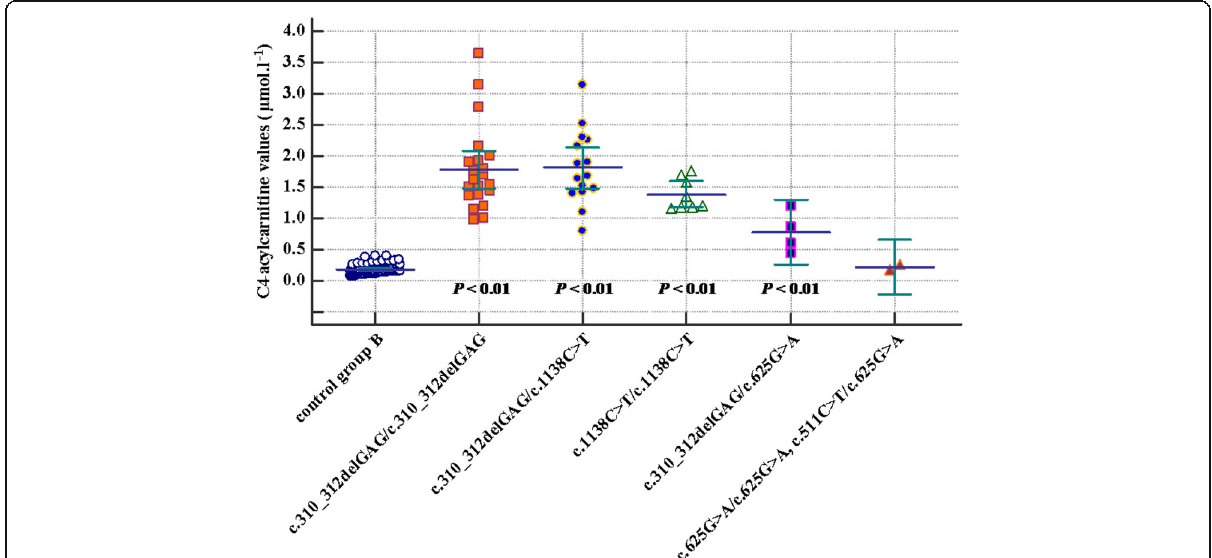
Fig. 2 A multiple variables graph (MedCalc® v15.11.4) showing C4-acylcarnitine values ( μ mol.l − 1 ) in control group B compared with C4-acylcarnitine values sorted according to SCADD genotype and statistical significance related to the control